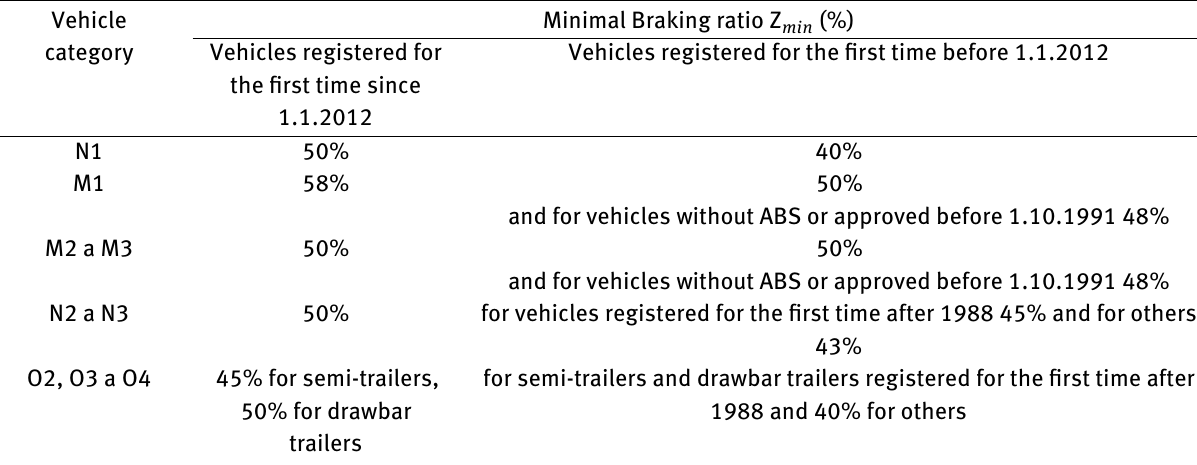
Table 1: The values of prescribed minimum braking ratios. Source: [1] Vehicle Minimal Braking ratio Z min (%) category Vehicles registered for the first time since 1.1.2012